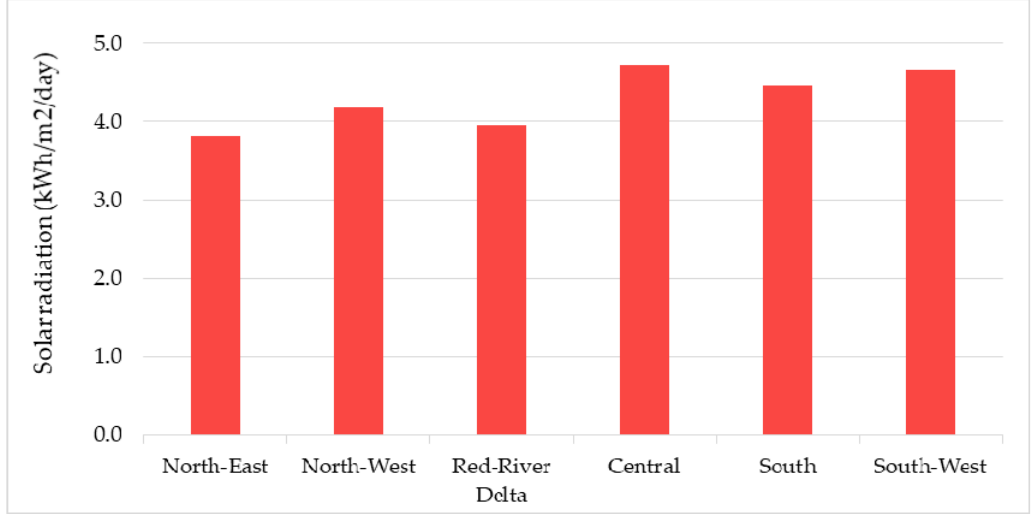
Figure 4. Chart of annual average of daily solar irradiation by VNMHA.